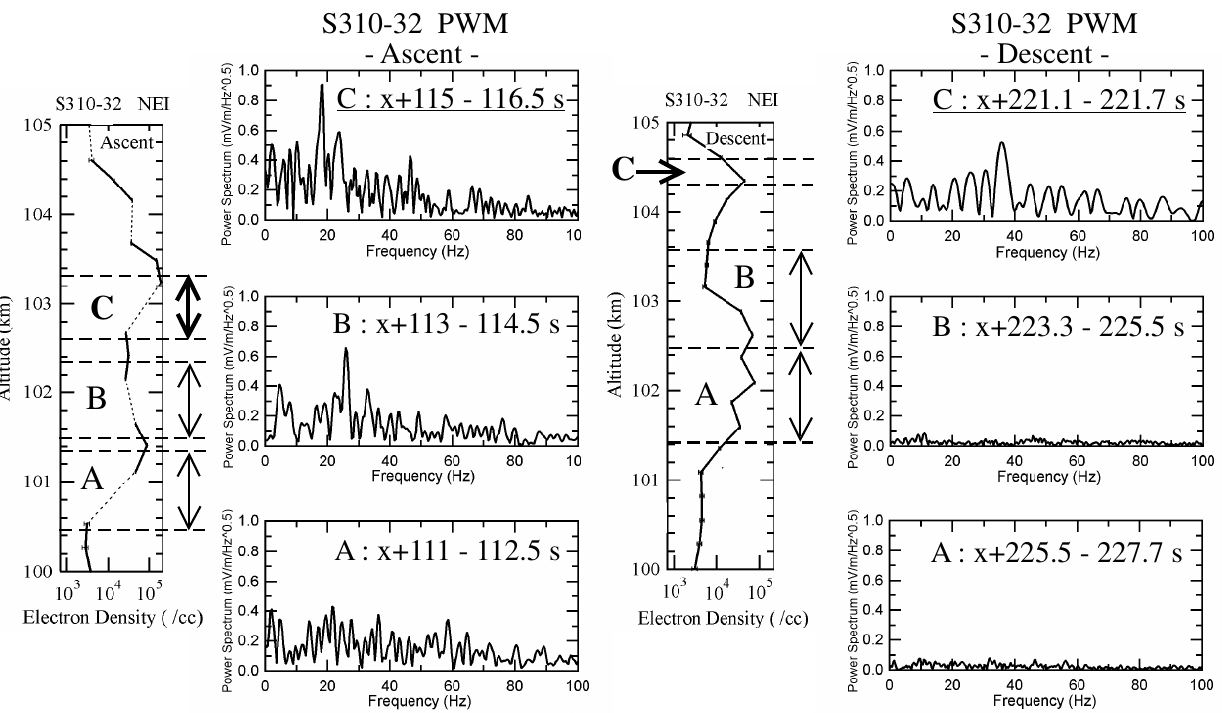
Fig. 6. The plasma wave spectra (FFT spectra) during passage through the sporadic- E . The left and right panels are in the ascending and descending phases of the S310-32